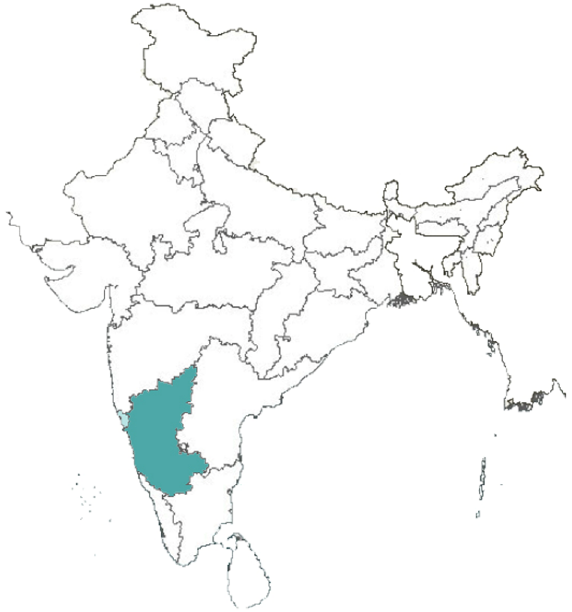
Fig 1. Map of India with Karnataka(highlighted) [Images available from: http://office.incometaxindia. gov.in/bengaluru/Pages/default.aspx].